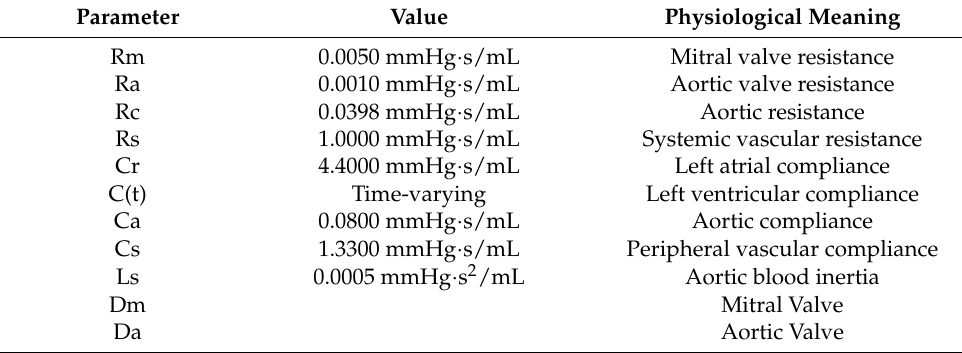
Figure 2. Healthy aortic flow and pressure curve at rest (heart rate = 75 bpm). Table 1. Parameters are used in 0D lumped-parameter circuit